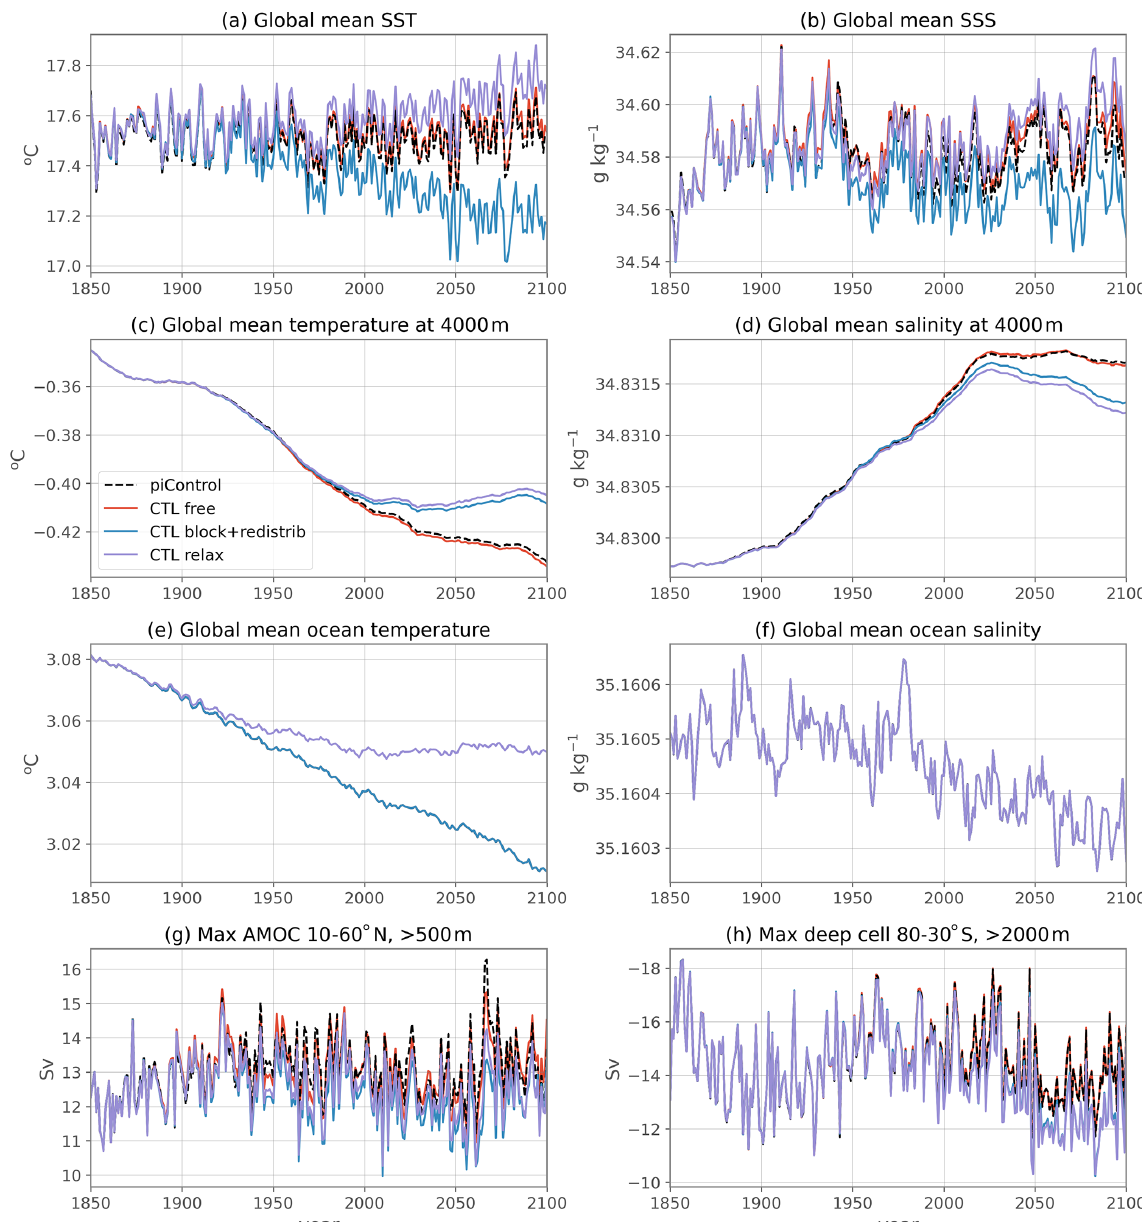
Figure A1. Annually averaged diagnostic time series for the coupled piControl (black); the flux-forced ocean-only CTL as presented in the main text, i.e., in which the temperature evolves freely (red); the CTL in which the temperature is blocked to the freezing point if it falls below it, and the equivalent heat flux that has been added to block the temperature is redistributed over the globe (i.e., removed) in the non solar heat flux (blue, option 1 in the text); and the CTL in which the temperature is relaxed to the freezing point if it falls below it (purple, option 2 in the text). In all three CTL cases, in the equation of state and computation of the Brunt–Väisälä frequency, the temperature is maintained at the freezing point if it falls below it (see Sect.